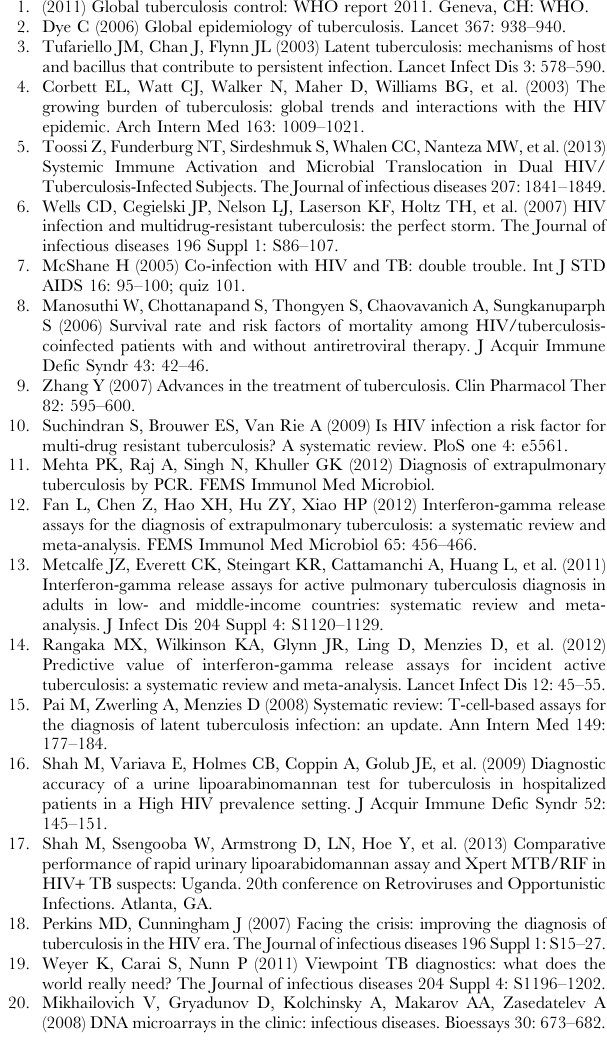
Figure S6 Changes in DNA Methylation Levels. Distribu- tion of genes based on the change in the percent methylation